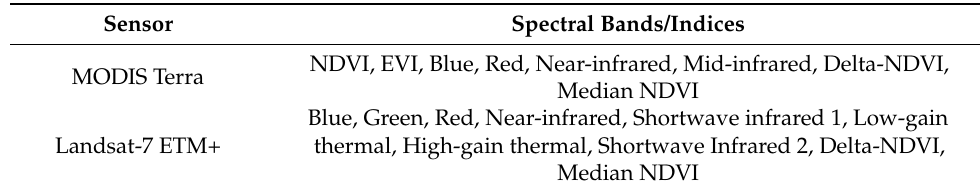
Table 1. MODIS and Landsat-7 ETM+ spectral bands and indices used in this